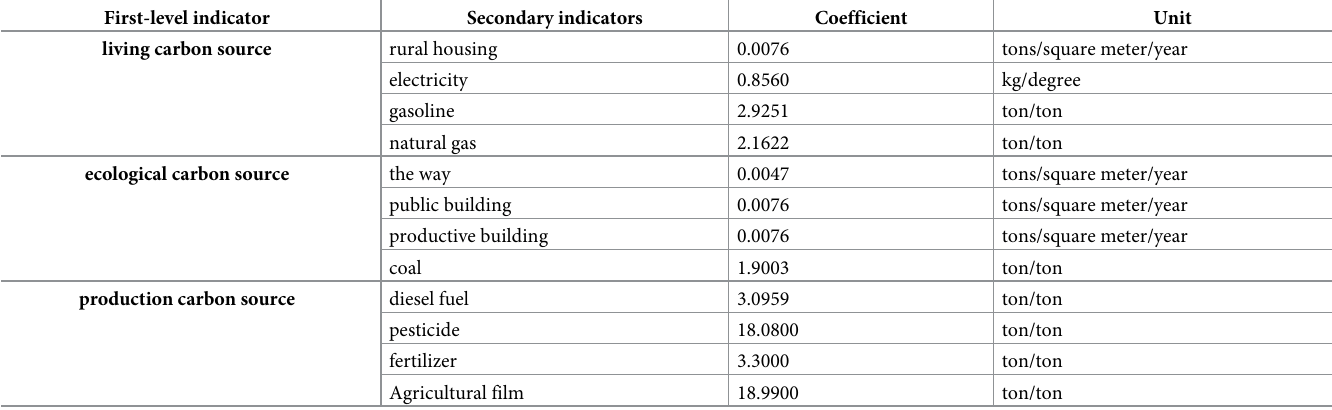
Table 1. Rural carbon emission sources and